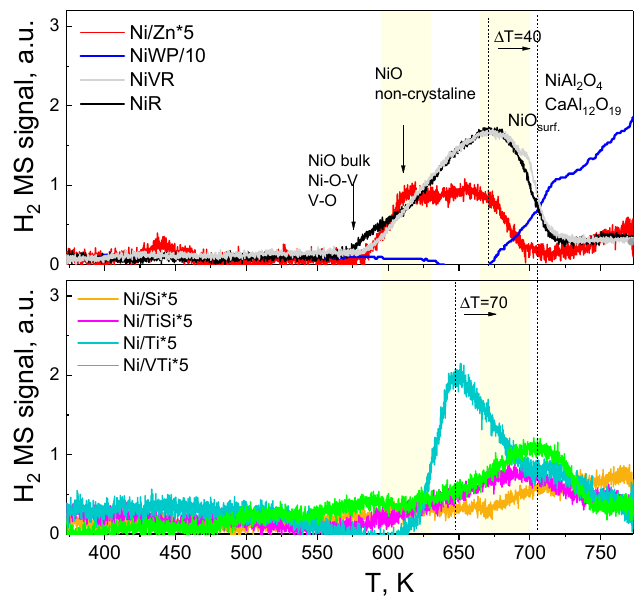
Figure 3. Temperature-programmed reduction (TPR) profiles of the catalysts (5% H 2 in He).